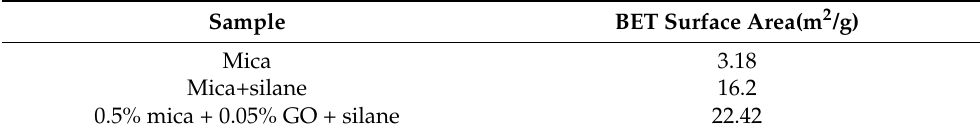
Table 1. Brunauer-Emmett-Teller (BET) surface area of mica before and after functionalization and mixed with graphene